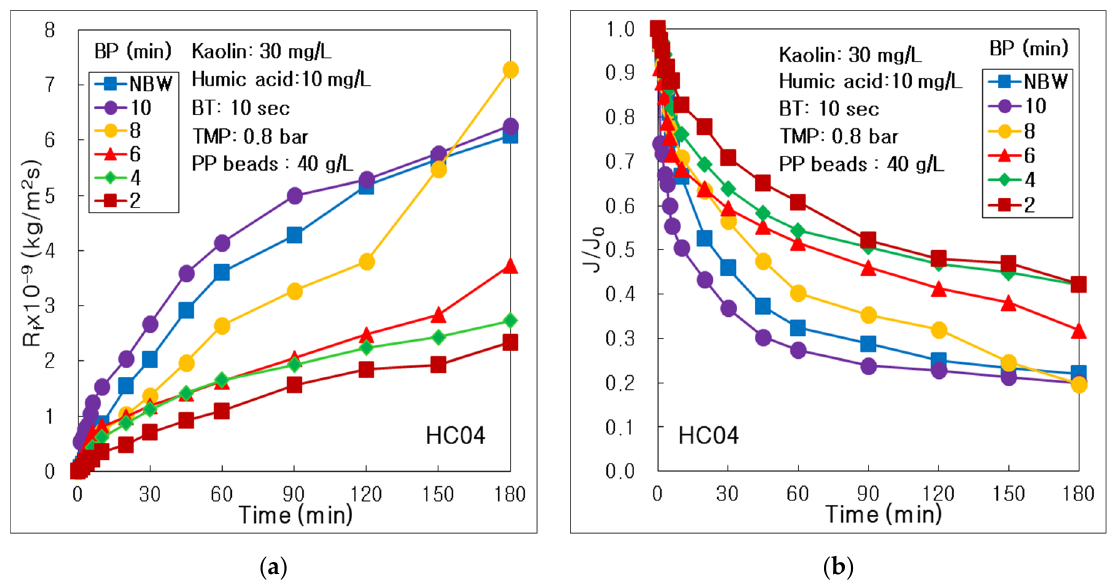
Figure 7. Influence of water backwashing period (BP) in the combined process of seven channel alumina MF (HC04) and PP beads with UV irradiation and periodic water backwashing: ( a ) Resistance of membrane fouling; ( b ) Dimensionless permeate flux. Table 8. Influence of water backwashing period on filtration factors in the combined process of seven channel alumina MF (HC04) membrane and PP beads with periodic water backwashing. BP (min) NBW